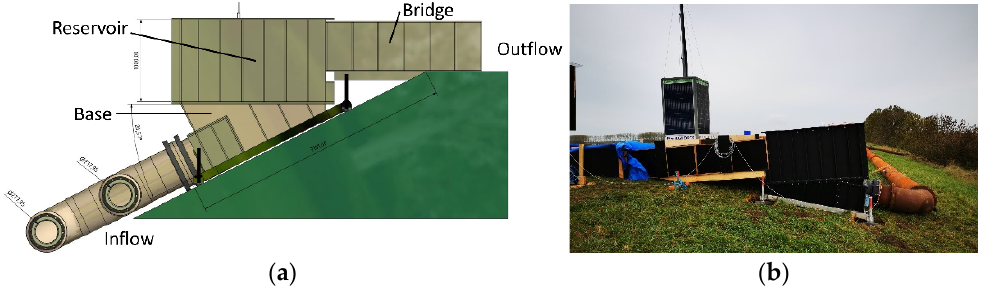
Figure 1. ( a ) Design drawing indicating main parts and ( b ) actual construction of the overflow gen-